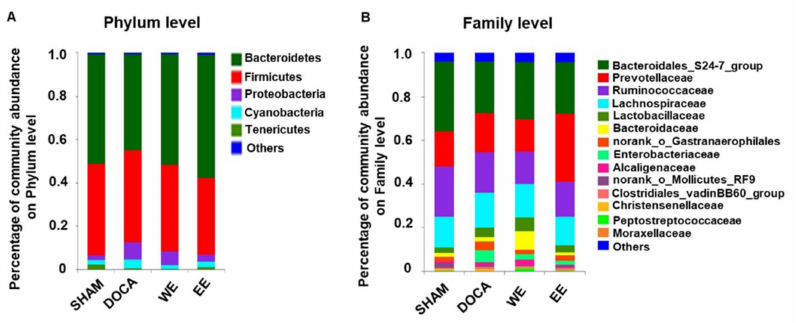
Figure 5. Effect of water extract and ethanol extract of L. rhamnosus AC1-fermented soymilk on the microbial composition in the gut flora of DOCA-salt hypertensive rats at week 14. Percentage of community abundance on the phylum ( A ) and family levels ( B